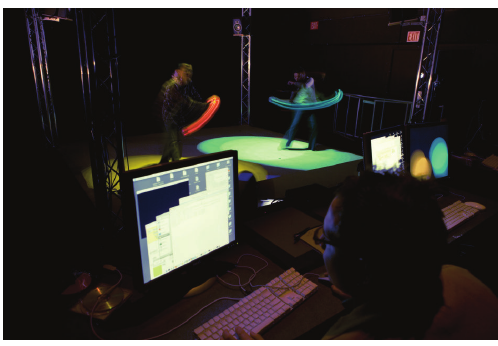
Figure 1: SMALLab mixed-reality learning